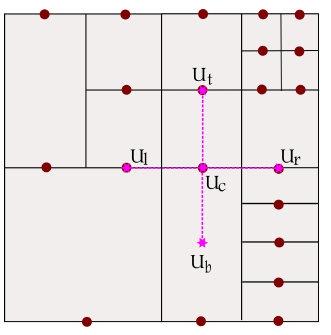
Figure 2. Finite difference 2nd-order stencil